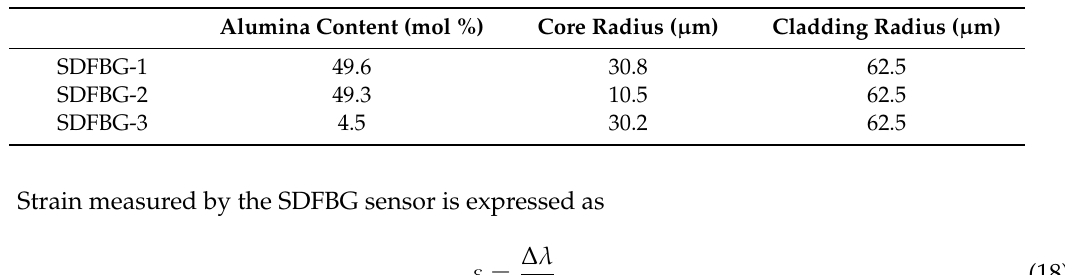
Table 3. Basic parameters of sapphire-derived fiber Bragg gratings (SDFBGs).